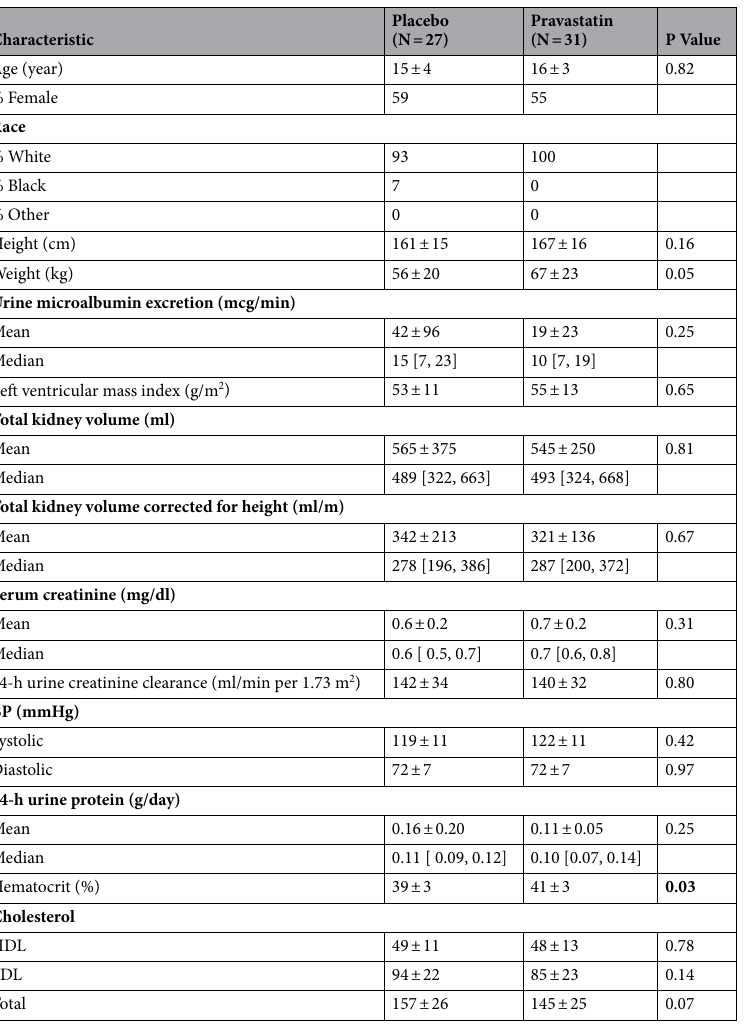
Table 1. Characteristics of the patients at the initial visit (N = 58). Samples from the same patients were available at the baseline and the 36-month time points (as reported in 12 ). Values are the mean ± SD or median [25th percentile, 75th percentile]. P < 0.05 considered significant